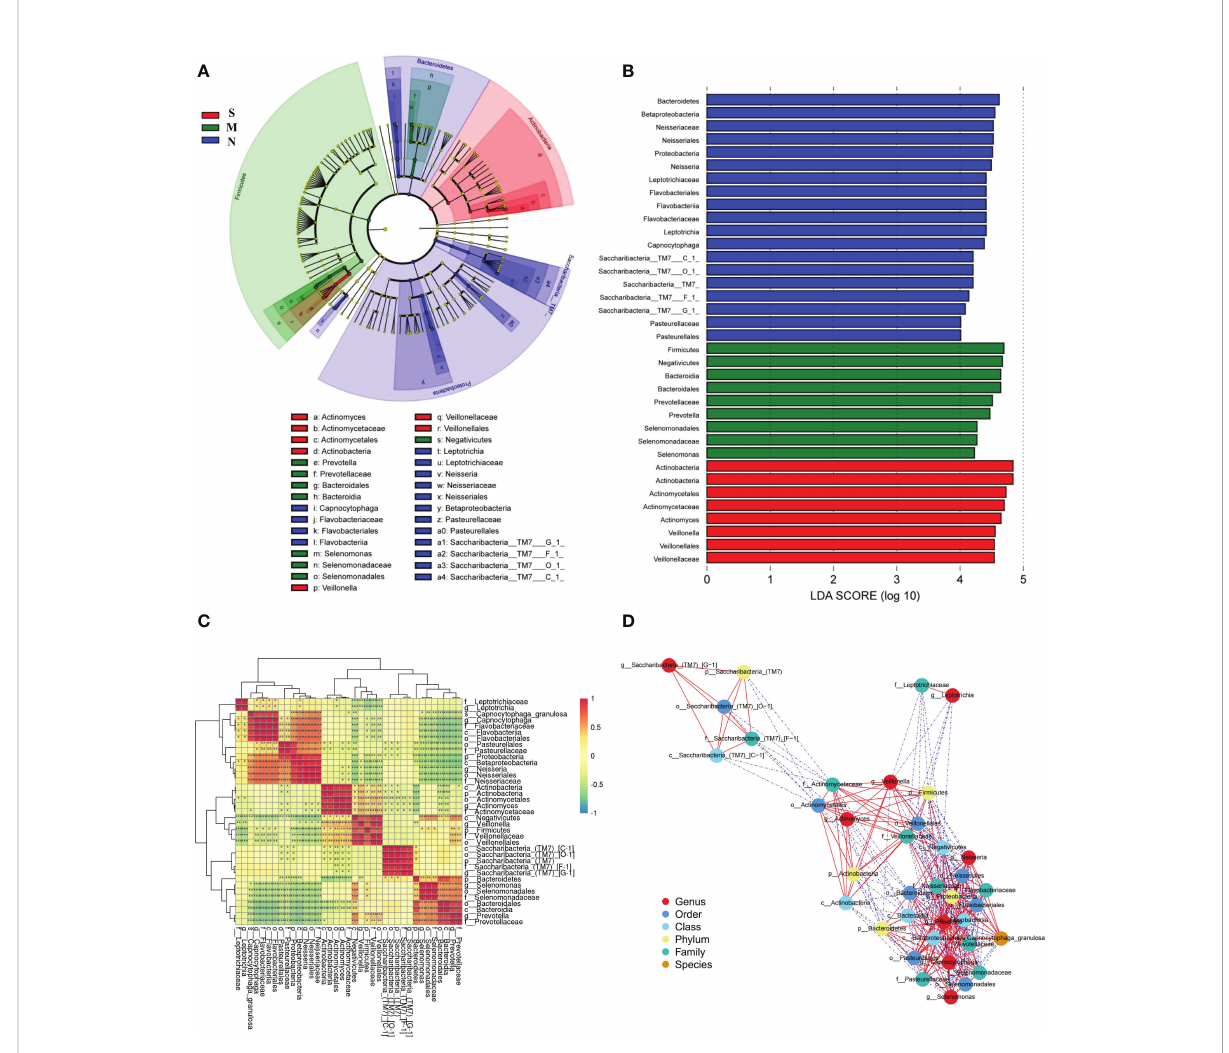
FIGURE 6 The speci fi c oral microbial differences and their correlation among all three groups. (A) The analysis of LEfSe reveals the predominant microbes in different groups. The color represents the respective group. (B) The bar chart above shows the microbes with signi fi cant differences whose LDA score is greater than the p value (Only the taxa meeting a signi fi cant LDA threshold value of >4 are shown), indicating that the biomarker had statistical differences. (C) Heatmap showing Spearman correlation coef fi cients of the selected biomarkers in (A, B) . (D) Bacterial co- occurrence and anti-occurrence were investigated and presented as a network. The nodes representing core bacterial genera (colored according to different levels), and edges representing interactions (red=co-occurrence, blue=mutual exclusion) at p < 0.05. Turkey-HSD analysis was used. * p value< 0.05, ** p value< 0.01, *** p value<